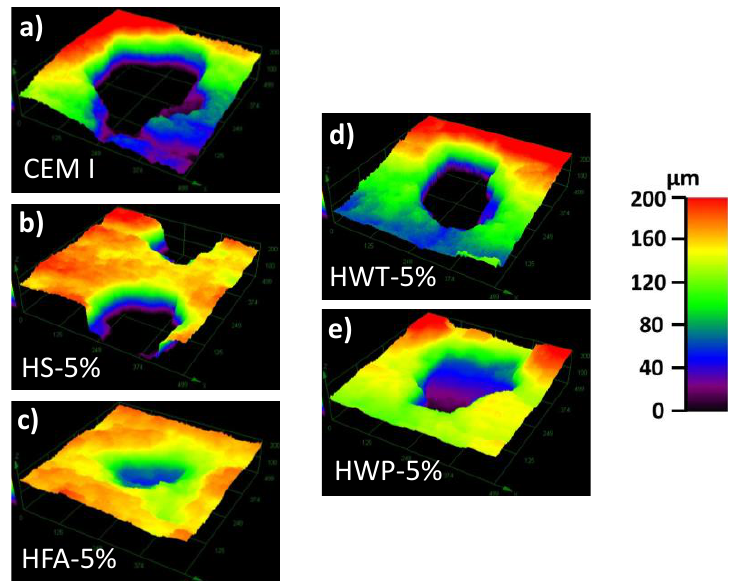
Figure 7. Profilometry 3D image of representative worn surfaces after the Böhme test of ( a ) CEM I, ( b ) HS-5%, ( c ) HFA-5%, ( d ) HWT-5% and ( e ) HWP-5%.